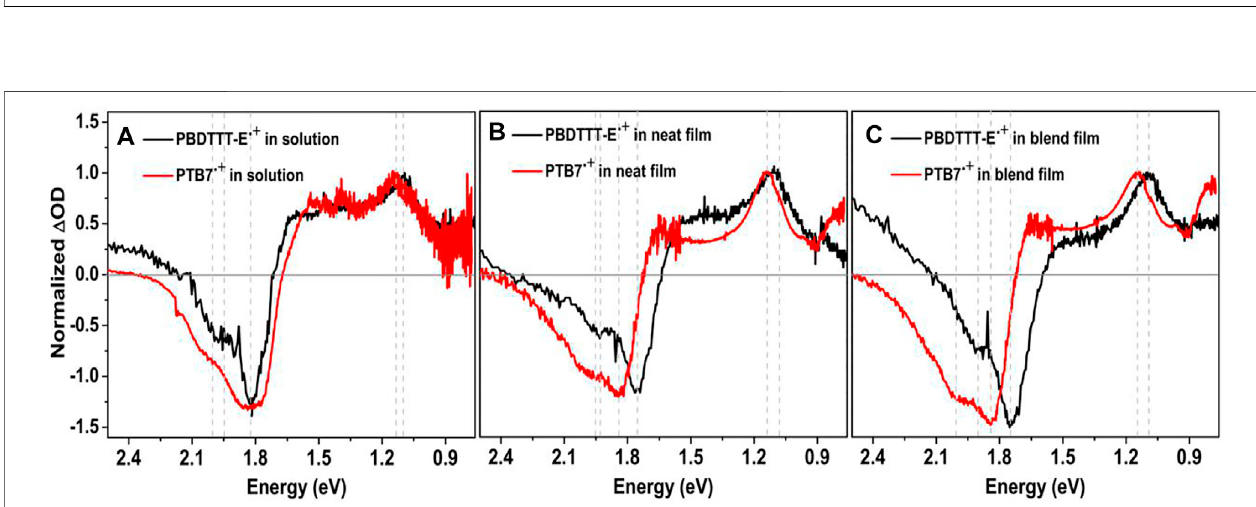
(cid:129) (cid:129) cm − 2 pulse − 1 ).